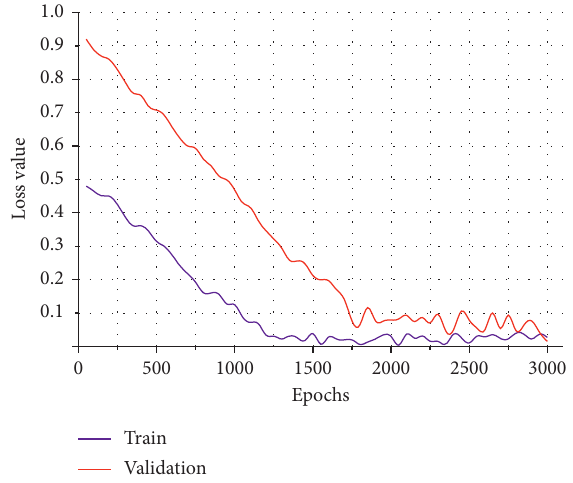
Figure 5: Network training on 3000